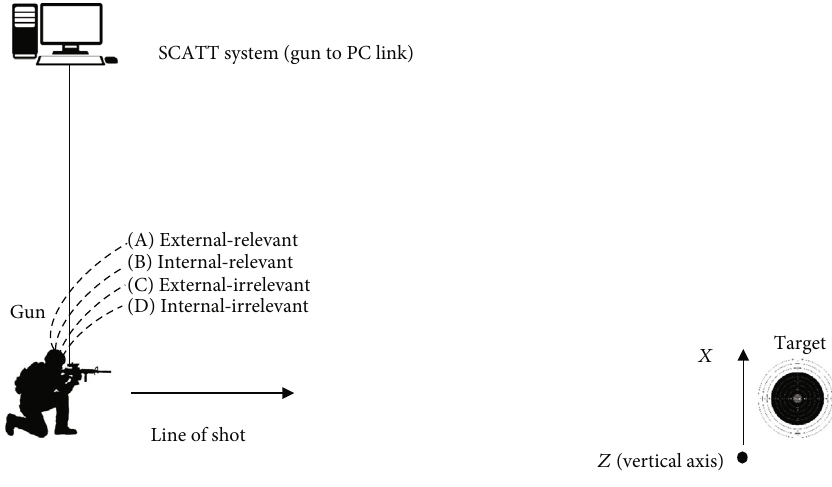
Figure 1: Testing setup.